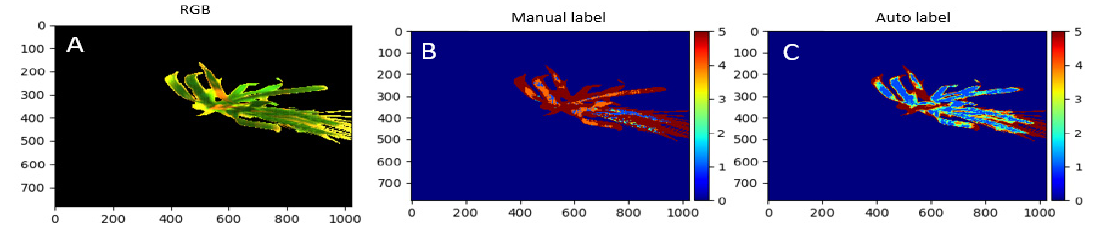
Figure 6. Comparison for soft wheat of the performances of the manually labelled model ( B ) with the automatically labelled model ( C ) with the red, green, and blue (RGB) representation of the hyperspectral image ( A ). Both the manually and automatically labelled datasets were fed into a logistic regression model, obtaining classification accuracies of 96.33% and 97.69% for the manual and automatic models, respectively. The color bar represents the label given by the automatic labelling algorithm.